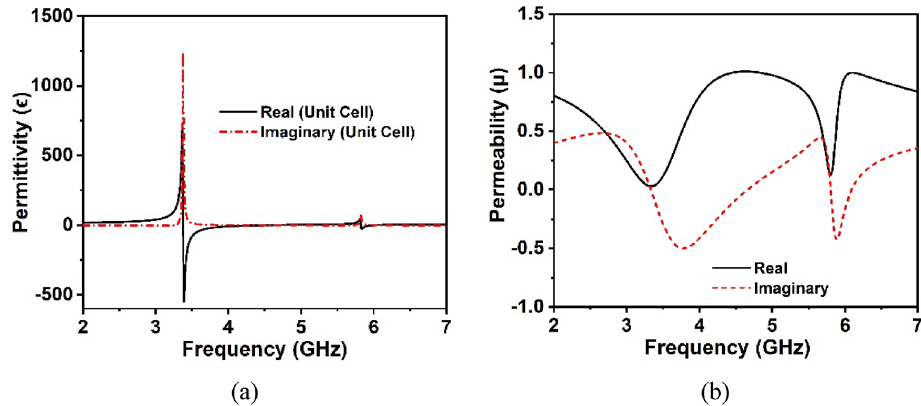
Figure 5. ( a ) Permittivity and ( b ) permeability (CST post processing approach) of the proposed unit cell at operating bands.